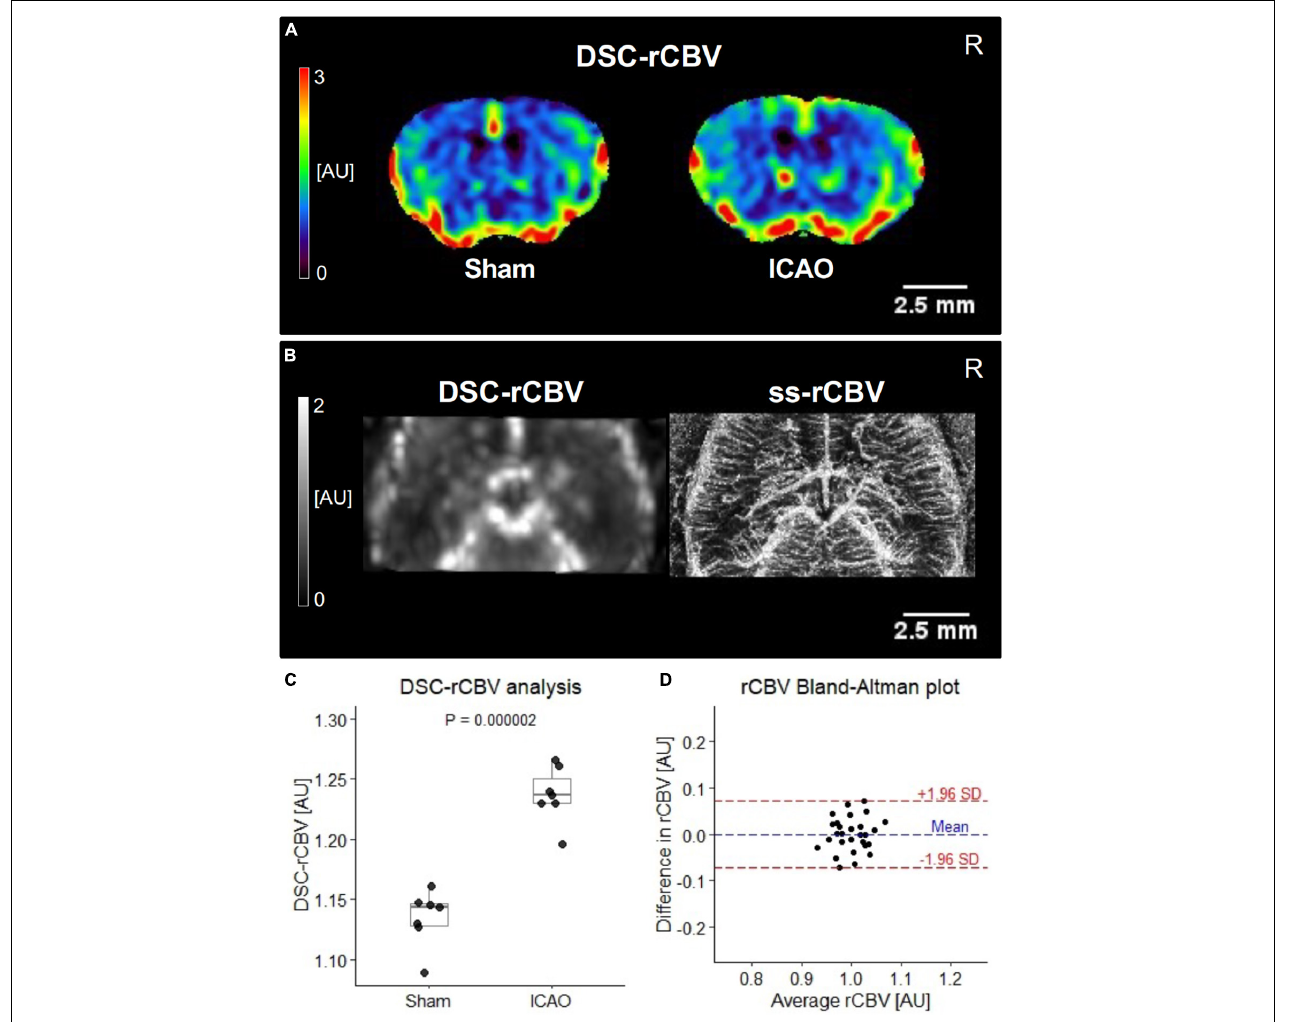
FIGURE 3 | Internal cerebral blood volume (CBV) validation. (A) Color-coded normalized dynamic susceptibility contrast-relative cerebral blood volume (DSC-rCBV) maps in arbitrary units (AU). (B) Comparison of normalized DSC-rCBV and ss-CBV map resolution for the same animal. (C) Comparison of iron oxide nanoparticle-based DSC-rCBV at Day 21 ( n = 7 per group). (D) Bland-Altman comparison of DSC-rCBV and ss-CBV in the right- and the left-sided neocortex ( n = 28). The average of ss-CBV and DSC-rCBV is plotted against their difference. A mean difference of 0.000007 AU in rCBV with limits of agreement between -0.07 and 0.07 AU was